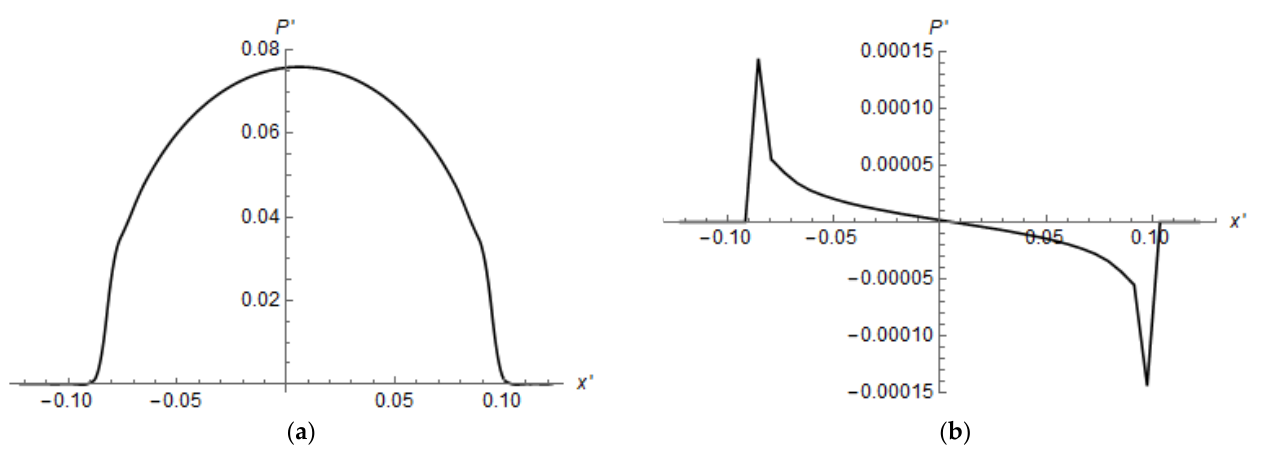
Figure 9. Contact pressure distributions ( a ), difference between contact pressures under left and right balls ( b ). E 1 / E 2 = 10 − 3 , ν 1 = 0.48, ν 2 = 0.3, L (cid:48) = 2.0, h (cid:48) = 1.16, Q (cid:48) = 2.66 ( 6 ) × 10 − 3